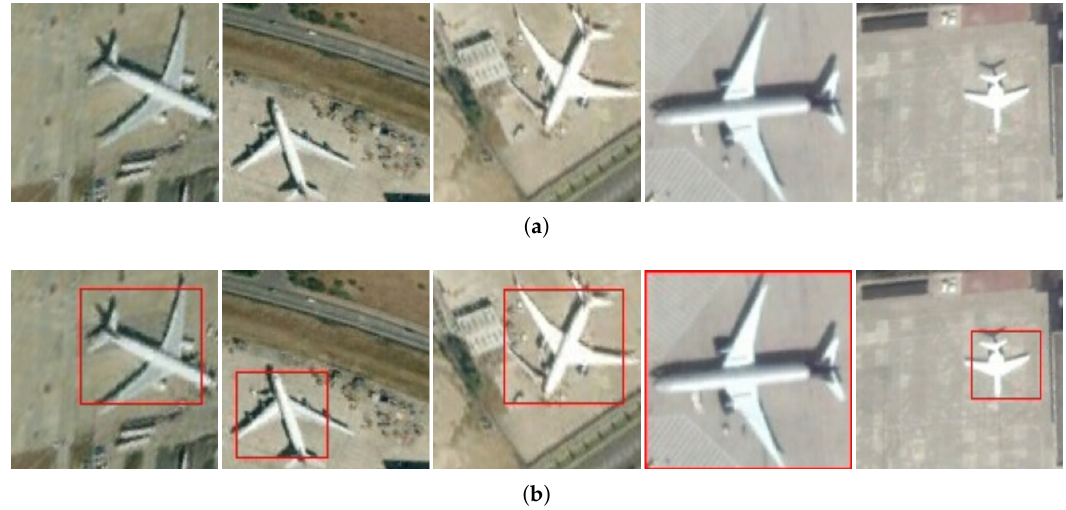
Figure 7. Display of the results that the detection agent localized on the clips generated from final 20 remote sensing images. All results are located with red bounding boxes. ( a ) the clips of remote sensing images generated by the restricted EdgeBoxes; and ( b ) the localization results of the clips through the detection agent.